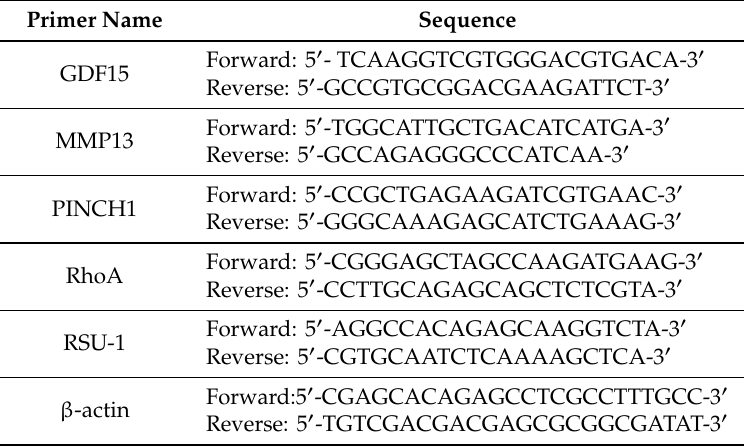
Table 1. Primer sequences used for real time